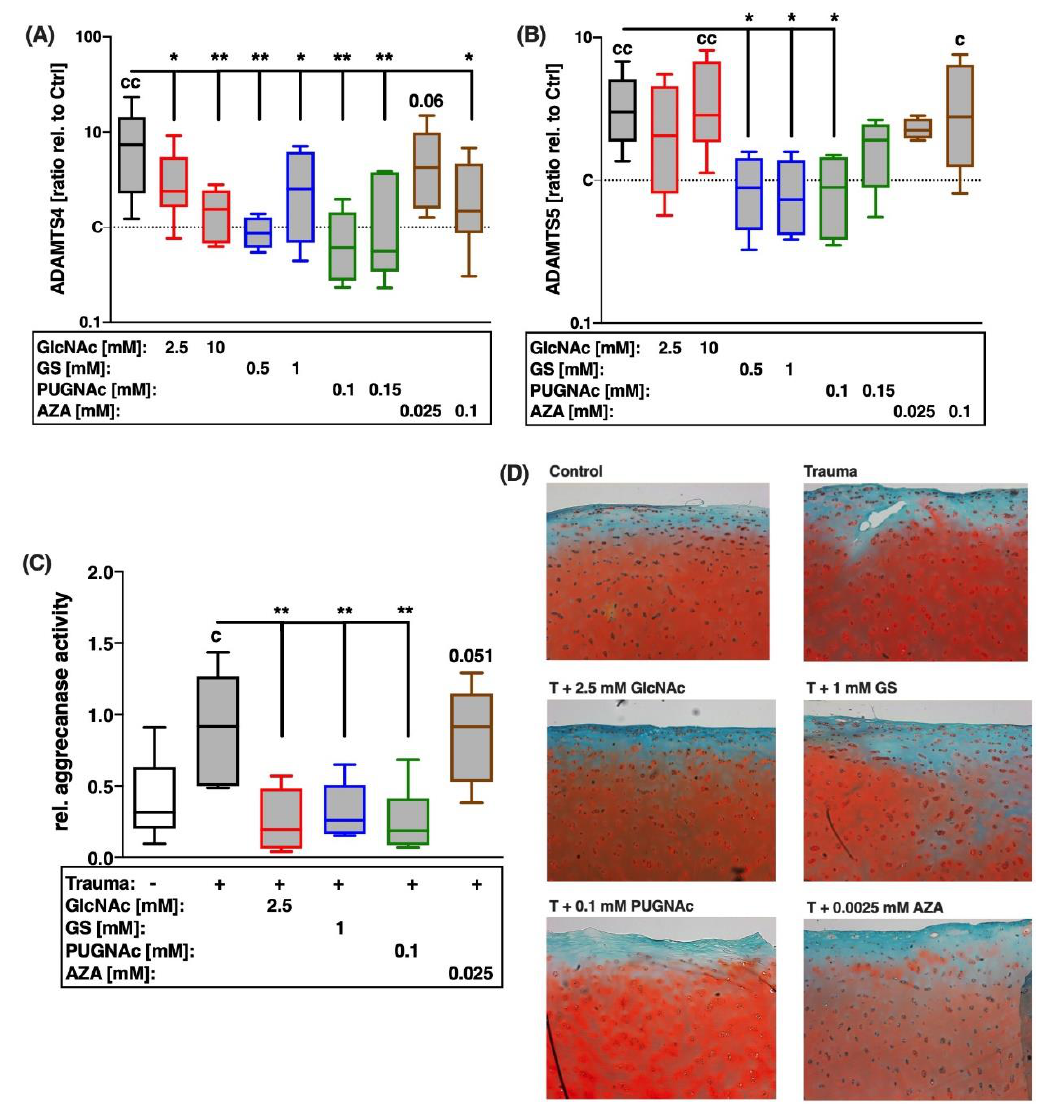
Figure 7. Effects of glucosamine treatment or addition of inhibitors on trauma-induced expression of aggrecanases and PG breakdown 7 days and 14 days after trauma. Catabolic processes were assessed by means of gene expression analysis of ( A ) ADAMTS-4 and ( B ) ADAMTS-5, as well as ( C ) quantification of relative aggrecanase activity (7 days after trauma). Moreover, ( D ) PG content in cartilage explants 14 days after trauma and corresponding treatments were evaluated by means of exemplary images of cartilage after Saf-O staining. Statistical analysis: ( A – C ) one-way ANOVA. Significant differences between groups were depicted as: [versus T] * = p < 0.05, ** = p < 0.01; [versus C] c = p < 0.05, cc = p < 0.01; all data sets n ≥ 5. Blank box = unimpacted control (C), shaded boxes = traumatized cartilage explants (T).